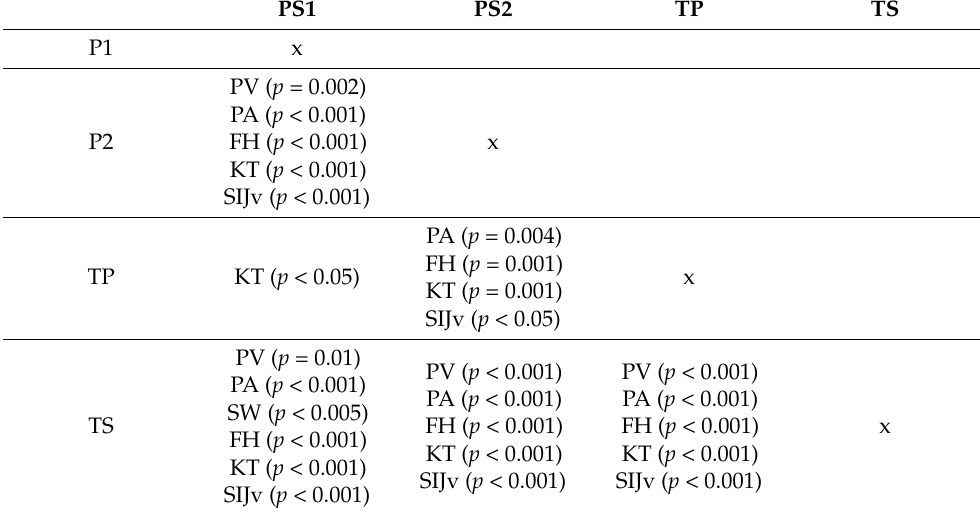
Table 2. Overview of the reduction results based on the mean values and standard deviation in direct comparison of the tested pelvic stabilizers to the native scans (PS1 = pneumatic pelvic sling VBM ® with applied pressure of 100 mmHg; PS2 = pneumatic pelvic sling VBM ® with applied pressure of 200 mmHg, TP = T-POD ® ; TS = cloth sling; SD = standard deviation; source: Haussmann [22], modified).